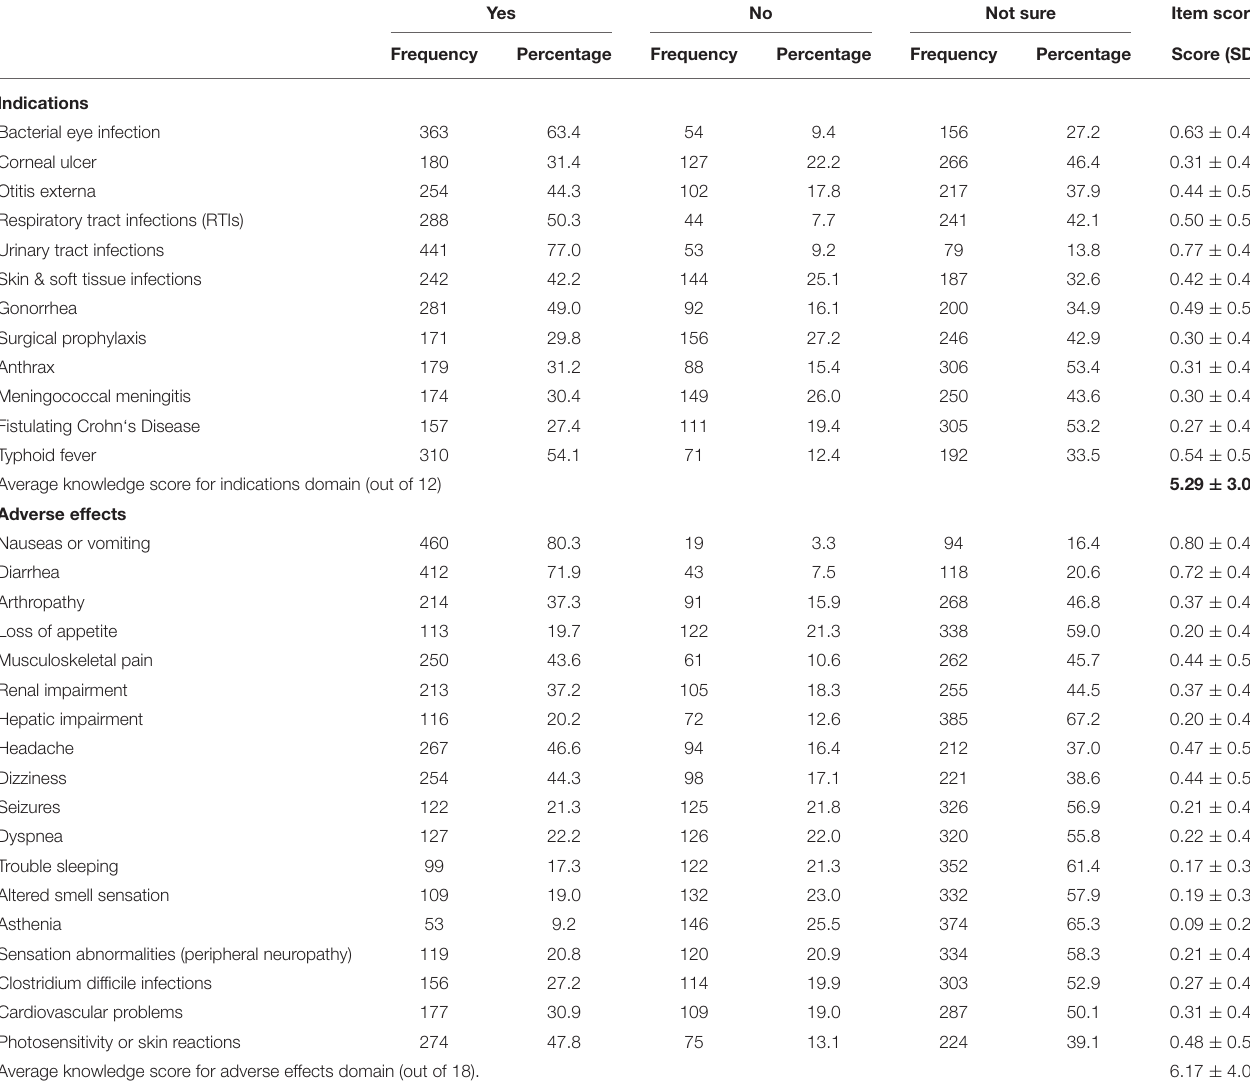
TABLE 3 | Participants’ knowledge toward indications and adverse effects of fluoroquinolones.